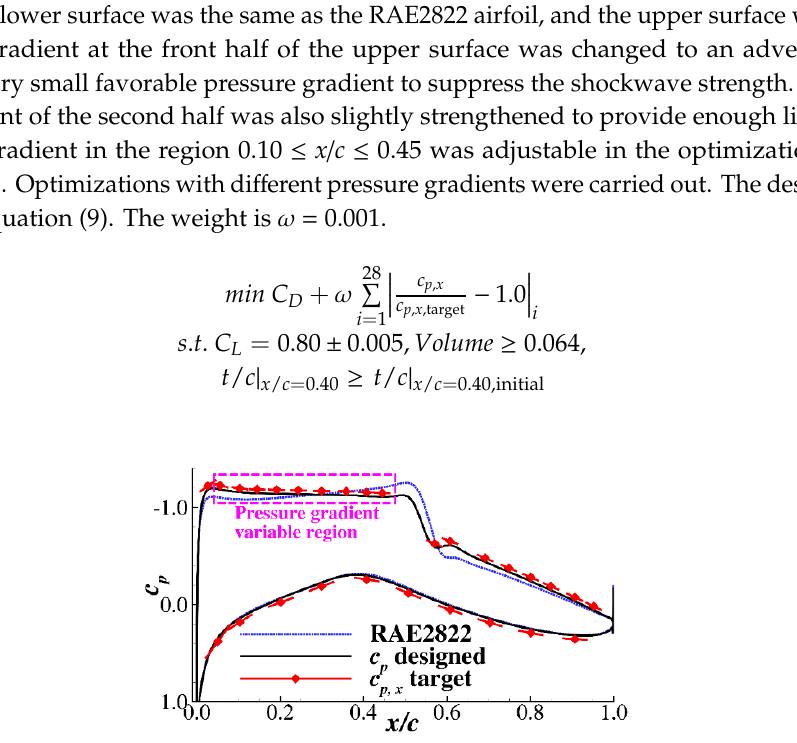
Table 5. Aerodynamic performance of the airfoils with different pressure gradients ( Ma = 0.73, Re = 6.5 × 10 6 ).